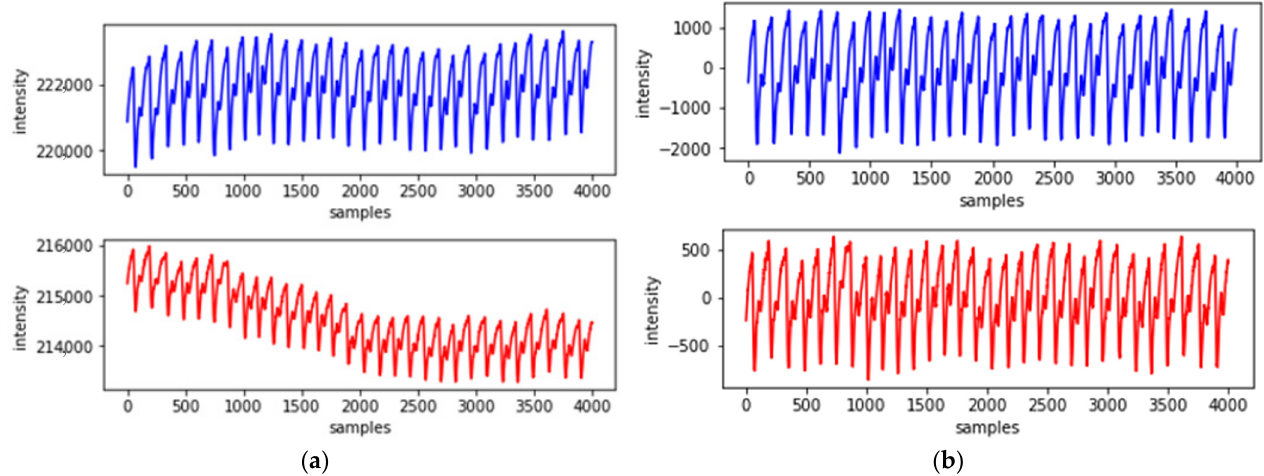
Figure 1. Dual-wavelength photoplethysmography (PPG) measurement waveform (blue line denotes red light, red line denotes infrared light); ( a ) original unprocessed PPG waveform; ( b ) PPG waveform filtered by a Savitzky–Golay filter.